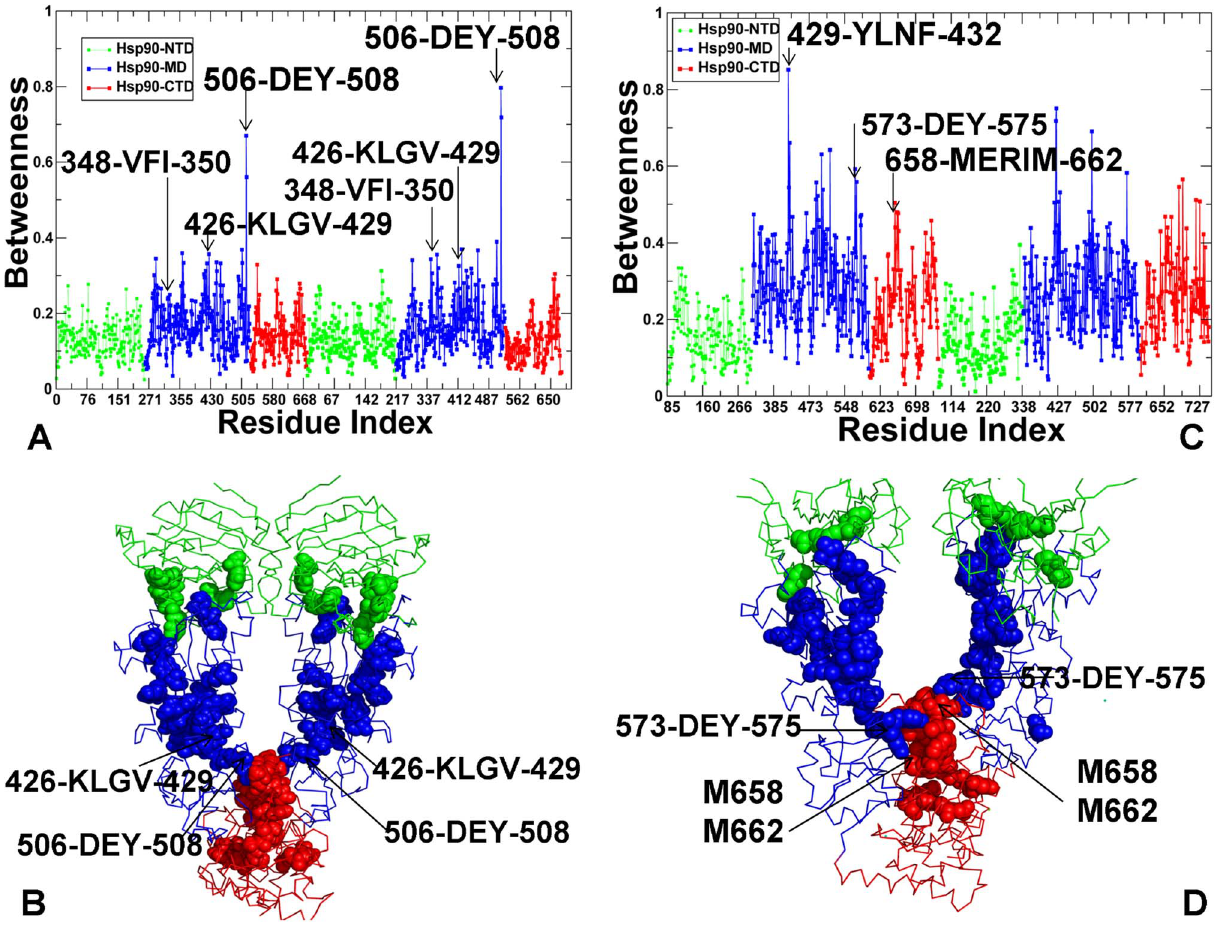
Figure 12. The Residue-Based Betweenness Profiles of the ATP-bound yeast Hsp90 and Grp94 Structures. The residue-based betweenness profiles are shown for the crystal structure of yeast ATP-Hsp90 (A) and the crystal structure of ATP-Grp94 (C). The betweenness profiles are shown in green for the NTD residues, in blue for the MD residues, and in red for the CTD residues. The peaks of the betweenness profiles corresponding to functionally important residues are indicated by arrows and annotated. Structural mapping of high betweenness residues that correspond to functionally important sites is shown for the crystal structure of yeast ATP-Hsp90 (B) and the crystal structure of ATP-Grp94 (D). The protein structures are shown in a backbone trace protein representation and colored according to their domain nomenclature as in Figure 11. The functional residues of high centrality are shown in spheres and colored according to their respective domains. Structural positions of high centrality residues are indicated by arrows.